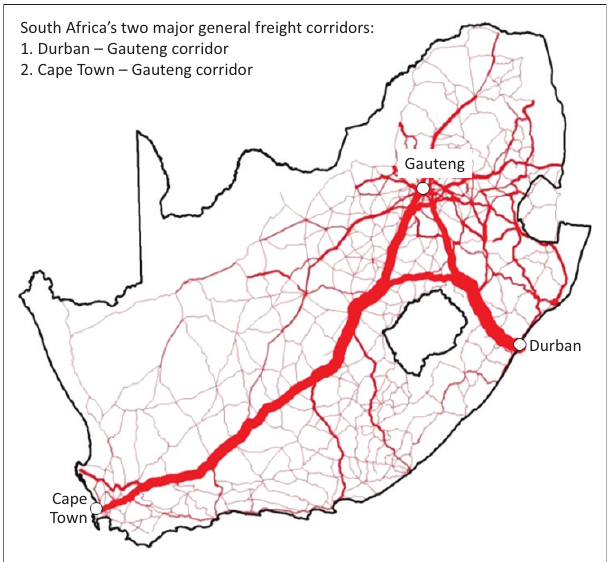
FIGURE 1: Geographical presentation of South Africa’s general freight flow density: two key freight corridors emerge.